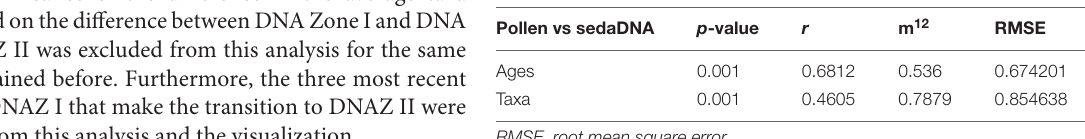
TABLE 1 | Results of Procrustes and PROTEST analyses indicate significant fit among all pairwise comparisons of datasets obtained by pollen and sedaDNA